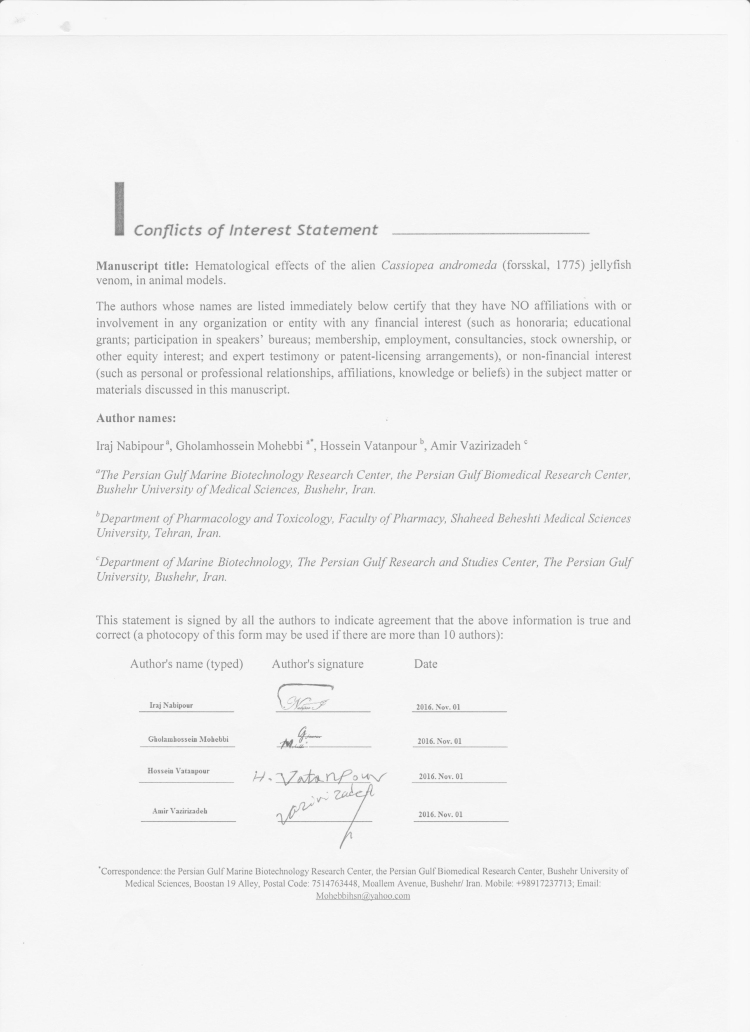
Supplementary material.